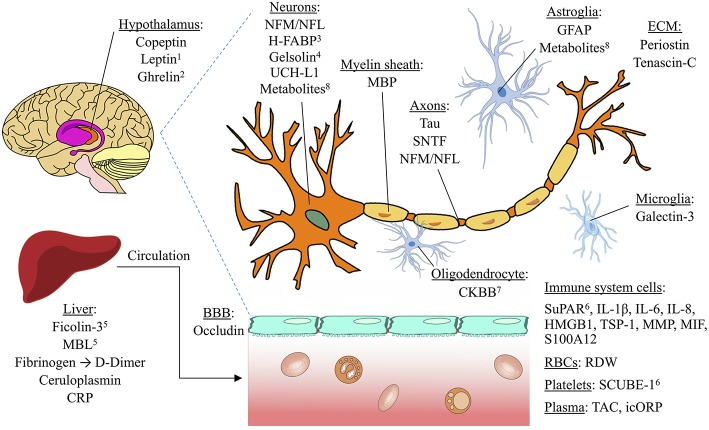
Anatomical locations of potential TBI biomarkers. The biomarkers included in this schematic all rated as “good” (AUC=0.800.89) or better for any of the four clinical situations studied (detecting concussion, predicting intracranial damage after concussion, predicting delayed recovery after concussion, and predicting adverse outcome after severe TBI). Biomarkers with a pooled AUC <0.8 are not shown. 1Also found in adipose tissue; 2synthesized in cells of stomach and pancreas; may regulate HPA axis; 3found mostly in pons; 4also found extracellularly; 5lectin pathway of the complement system; 6also found in endothelial cells. BBB, blood brain barrier. ECM, Extracellular matrix. Image licensed under Creative Commons Attribution-ShareAlike 4.0 International license. https://creativecommons.org/licenses/by-sa/4.0/deed.en. See Supplementary Material for image credits and licensing.